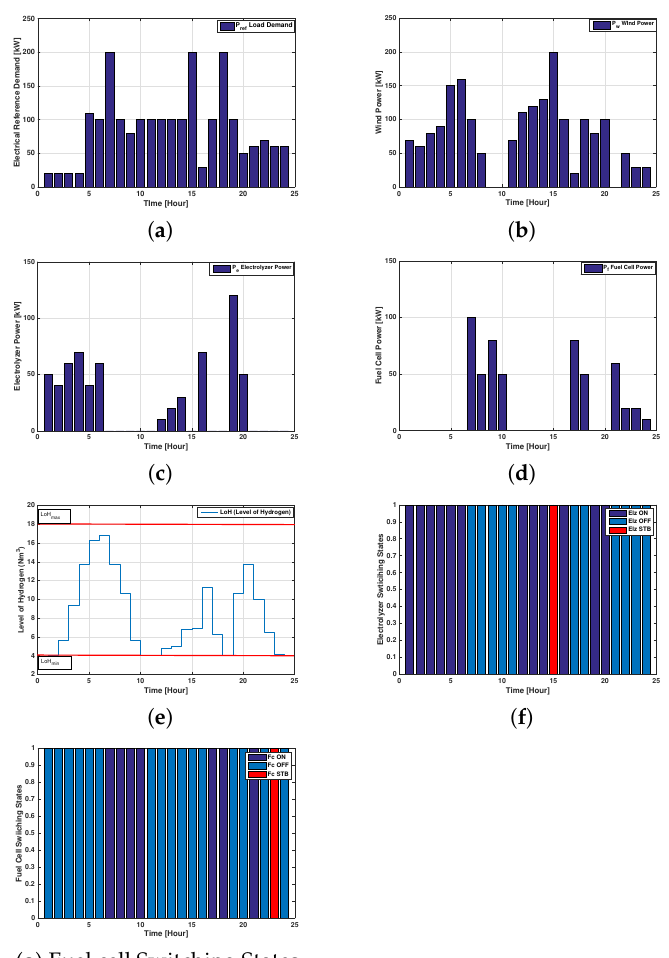
Figure 5. Numerical results for Example 2. ( a ) Electrical Reference Demand. ( b ) Forecasted Wind Power. ( c ) Power of the Electrolyzer. ( d ) Power of the Fuel Cell. ( e ) Level of Hydrogen. ( f ) Electrolyzer Switching States. ( g ) Fuel cell Switching